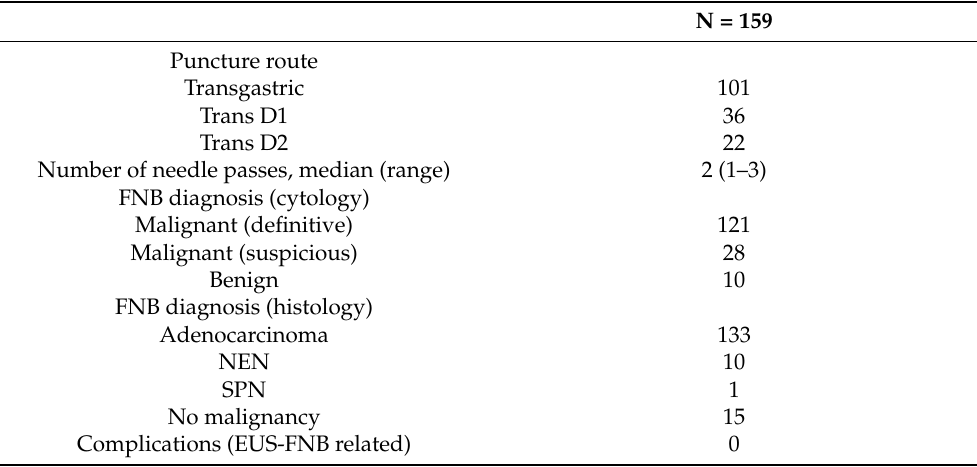
Table 2. Detailed data of endoscopic ultrasound-guided fine needle aspiration biopsy (EUS-FNB).